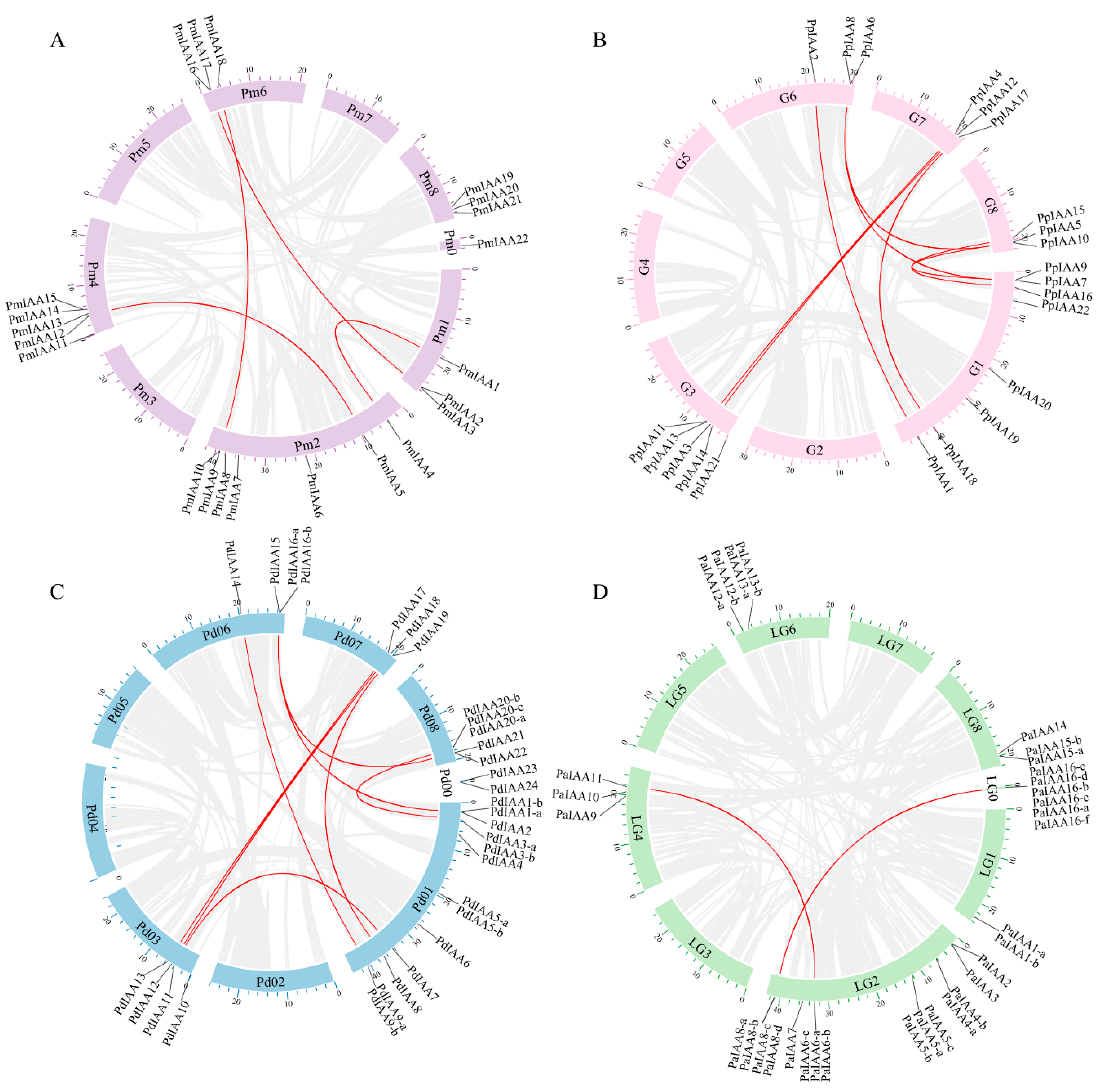
Figure 4. Segmental duplications of RoIAAs in P. mume , P. persica , P. dulcis , and P. armeniaca . Each scale of circle indicates a chromosome or fragment obtained RoIAAs . Gray lines indicate collinear relationships among the synteny blocks in a whole genome, and red lines highlight segmental duplication gene pairs of RoIAAs . ( A – D ) Segmental duplications of PmIAAs (purple), PpIAAs (pink), PdIAAs (blue), and PaIAAs (green), respectively. Gene names are emphasized at the outside of chromosomal boxes.